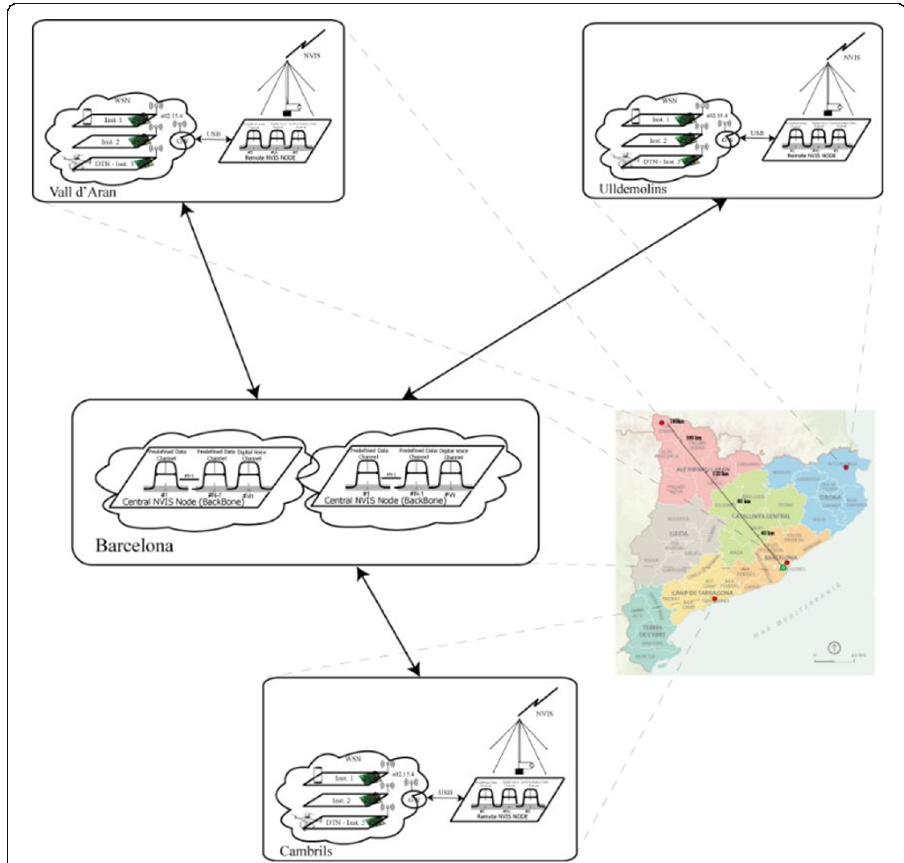
Fig. 21 Catalonia Nodes distribution. Distribution of the real test implemented in Catalonia. Three remote nodes were installed to test and get the results of the network analysis. A central node with redundancy was also installed. The remote nodes were situated between 100 and 200 km away from the central node